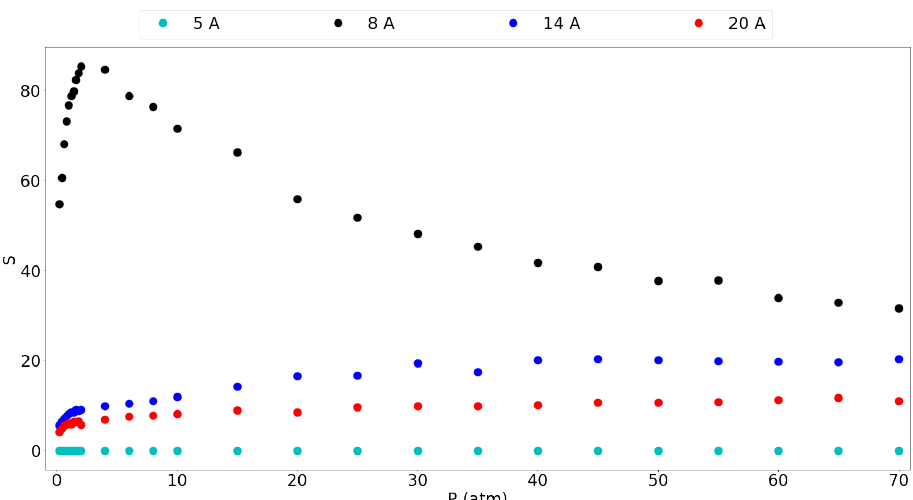
Figure 5. Selectivity for the different pores of methane over hydrogen for an equimolar mixture in the entire considered pressure